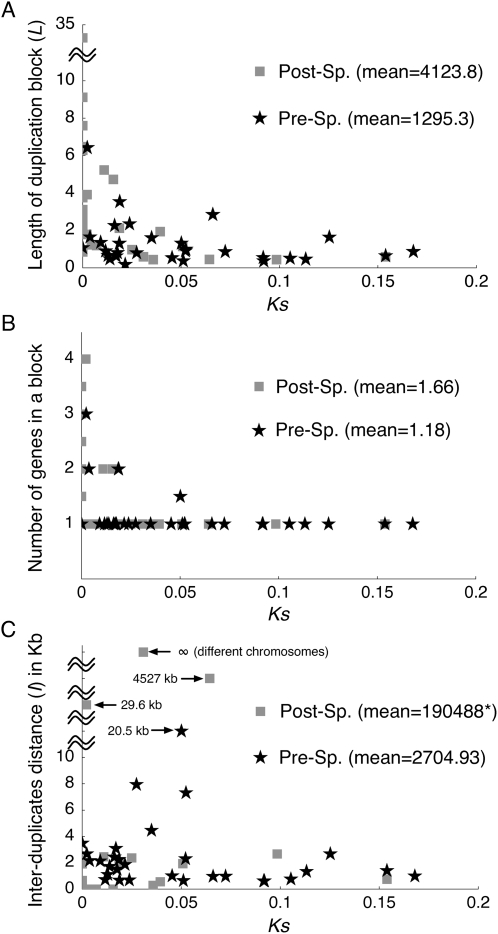
Decay of duplicated blocks.(A) Length of duplicated blocks (L) vs. synonymous divergence (KS). (B) Number of annotated genes vs. KS. (C) Length of intervening region (I) vs. KS.